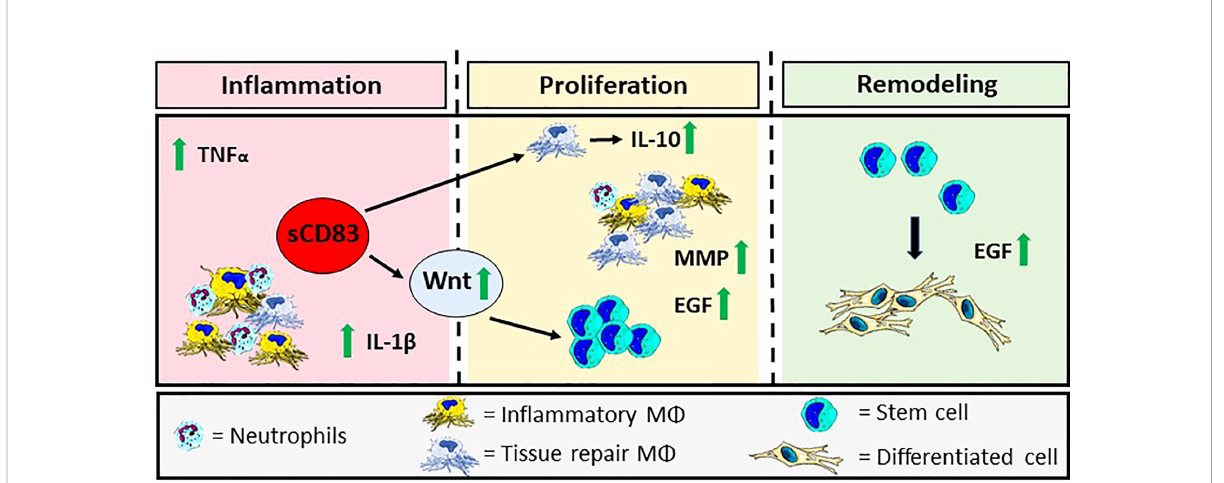
FIGURE 6 Graphical Overview: sCD83-treatment accelerates cutaneous wound healing modulating the three phases of wound closure. sCD83 boosts the natural kinetics of the in fl ammatory-, proliferative- and remodeling phases, during the wound healing process. Initially, the in fl ammatory phase, within wound sites of sCD83-treated mice, was increased and prolonged, as indicated by upregulated TNF a and IL-1 b levels, while IL-10- expression was delayed, until the proliferative phase. During wound healing YM-1 + sCD83 induced resolving M F are responsible for the secretion of IL-10 and the resolution of in fl ammation. Concomitantly, growth factors such as EGF and MMP remodeling enzymes are released by alternatively activated M F in order to restore tissue function and quality. Furthermore, the canonical Wnt-signaling cascade, which is related to epithelial stem cell proliferation, is boosted at earlier time points in order to replace the ablated tissue. The biological consequences are re fl ected in the increased presence of blood vessels in wounds of sCD83-treated